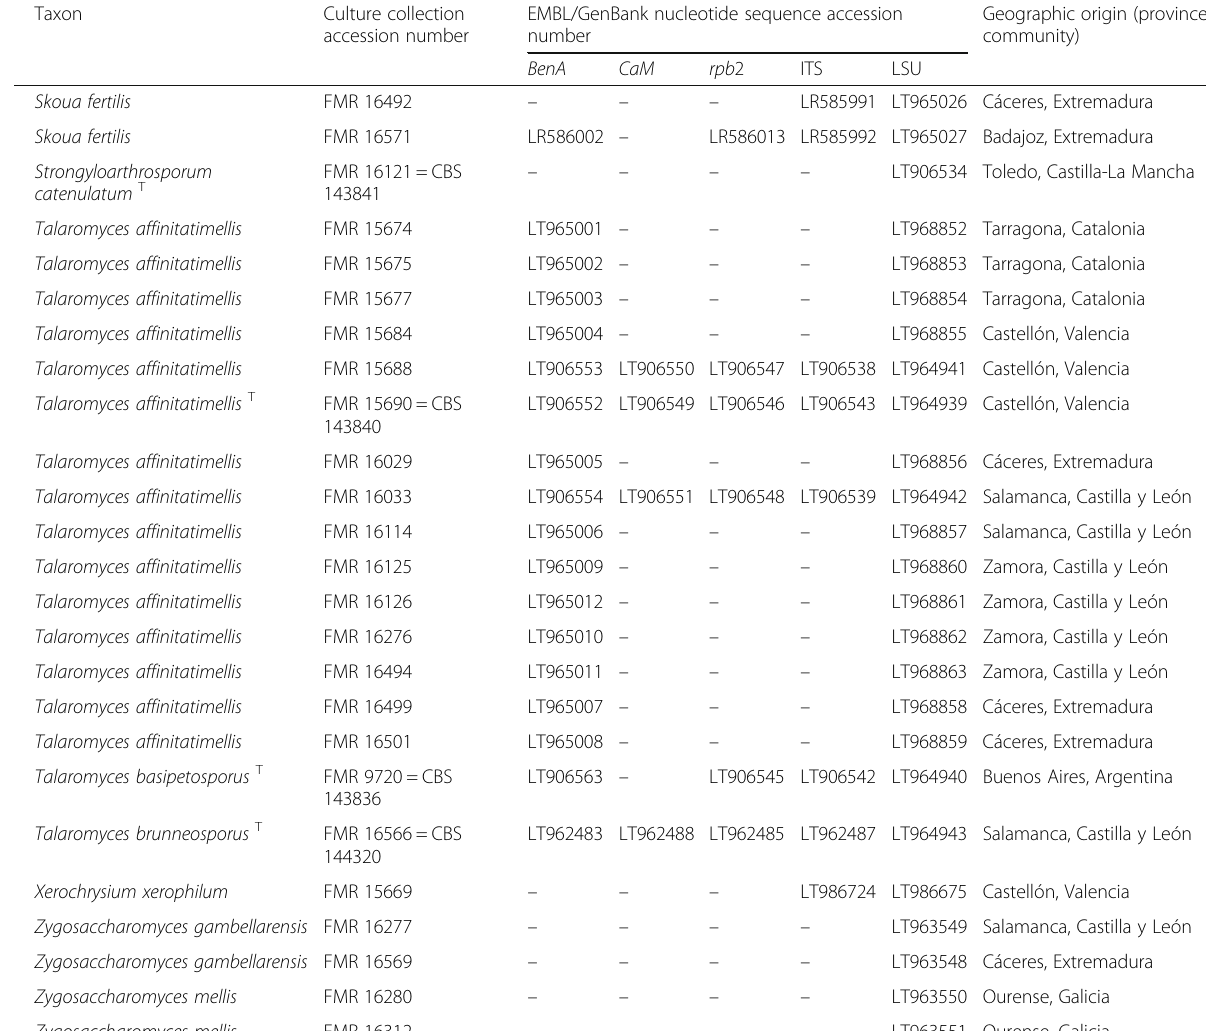
Table 1 Fungal taxa recovered with their nucleotide sequence accession number, and the geographic origin of the honey samples processed